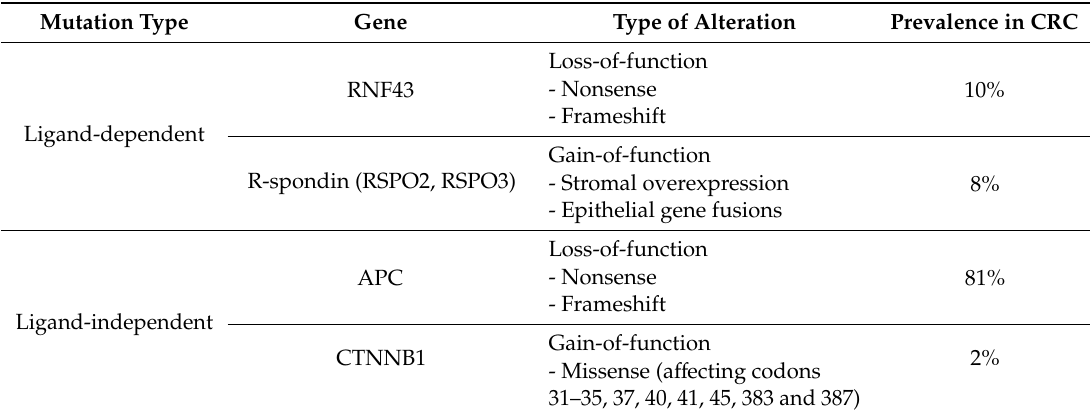
Table 1. Driver Wnt alterations in colorectal cancer. Prevalence refers to the frequency of each mutation in the subset of colorectal tumors with a detectable driver Wnt alteration, as derived from [42]. Loss-of-function alterations in APC and RNF43 are frequently accompanied by loss of heterozygosity (LOH) a ff ecting the second allele